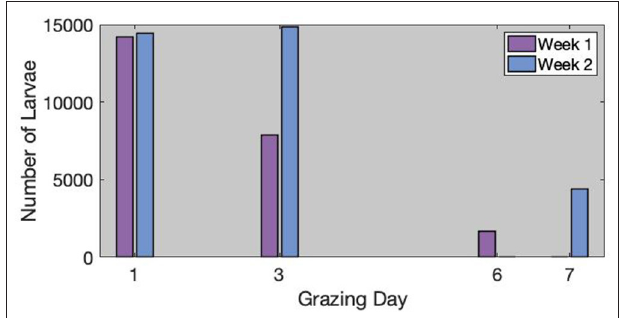
FIGURE 2 | Estimated number of larvae inside each infected areas for week 1 (left) and week 2 (right) . We used square mark when the number of larvae was estimated from the control samples, and star marks when it was interpolated from the observations.